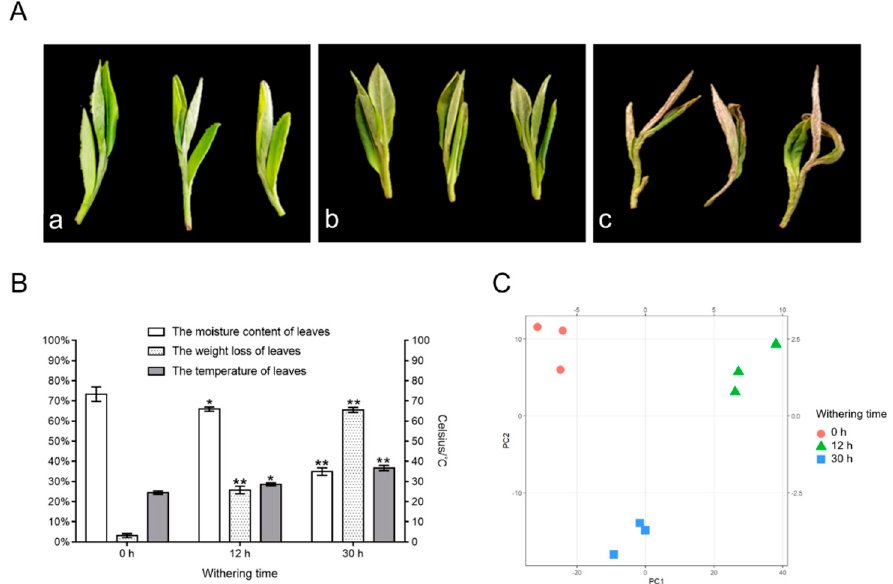
Figure 1. The tea leaf changes in water content, weight loss, temperature, and overview of nonvolatile compounds. ( A ) The phenotype of the picked tea leaves at 0 h (a), 12 h (b), and 30 h (c). ( B ) The moisture content, weight loss, and temperature of tea leaves following withering for different time periods. Data represent the mean value ± standard deviation (n = 3), * p < 0.05 compared with the sample of 0 h, ** p < 0.01 compared with the sample of 0 h. ( C ) Principal component analysis score plot of tea leaves with different withering times (0 h, 12 h, and 30 h).